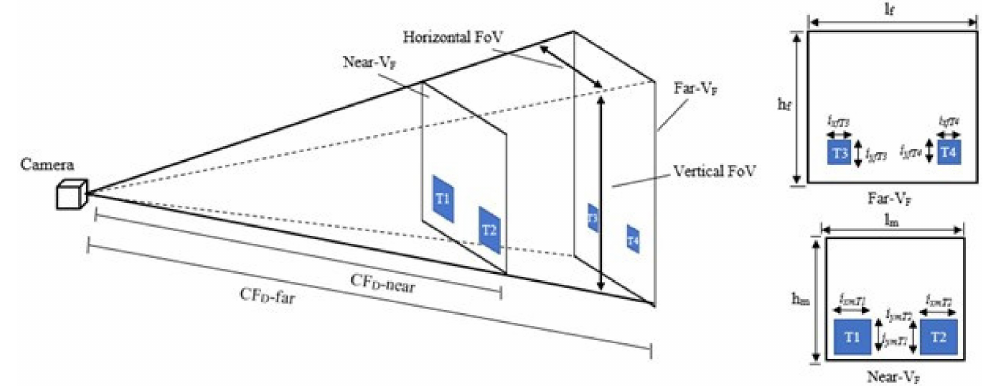
Figure 4. Real-world arrangements of ToF-based video